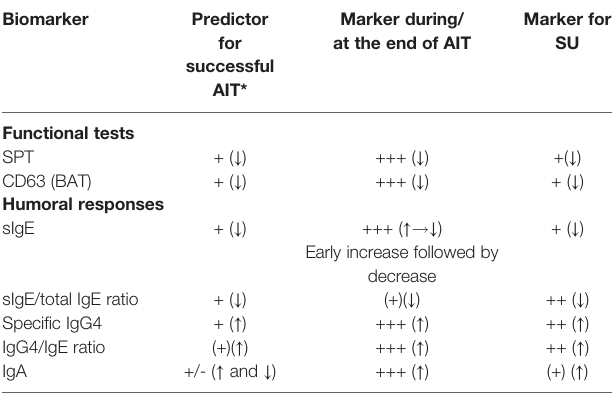
TABLE 1 | Immunological markers and their potential predictive value in food AIT. Biomarker Predictor for successful